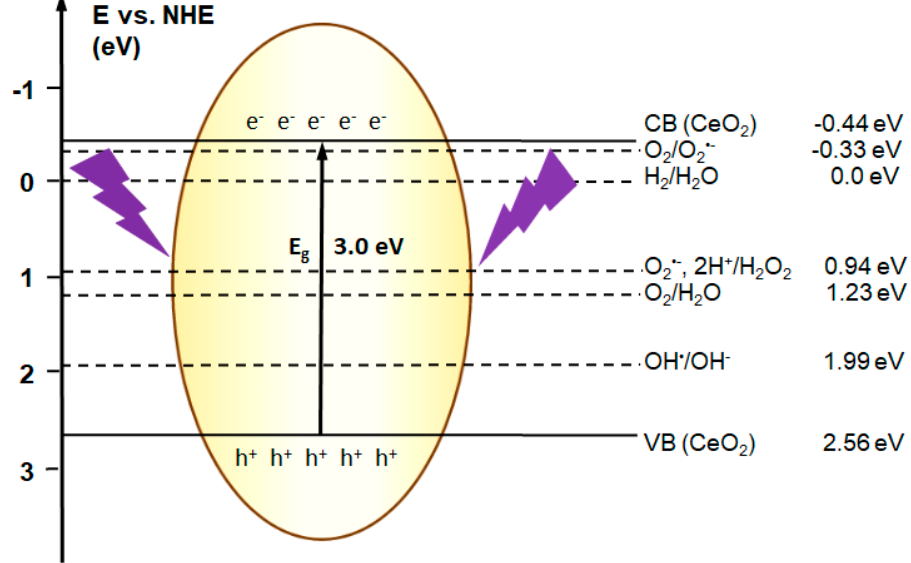
Figure 1. Band position (valence band top and conduction band bottom) of cerium dioxide (CeO 2 ) compared with several selected redox potentials of processes occurring at the semiconductor surface.